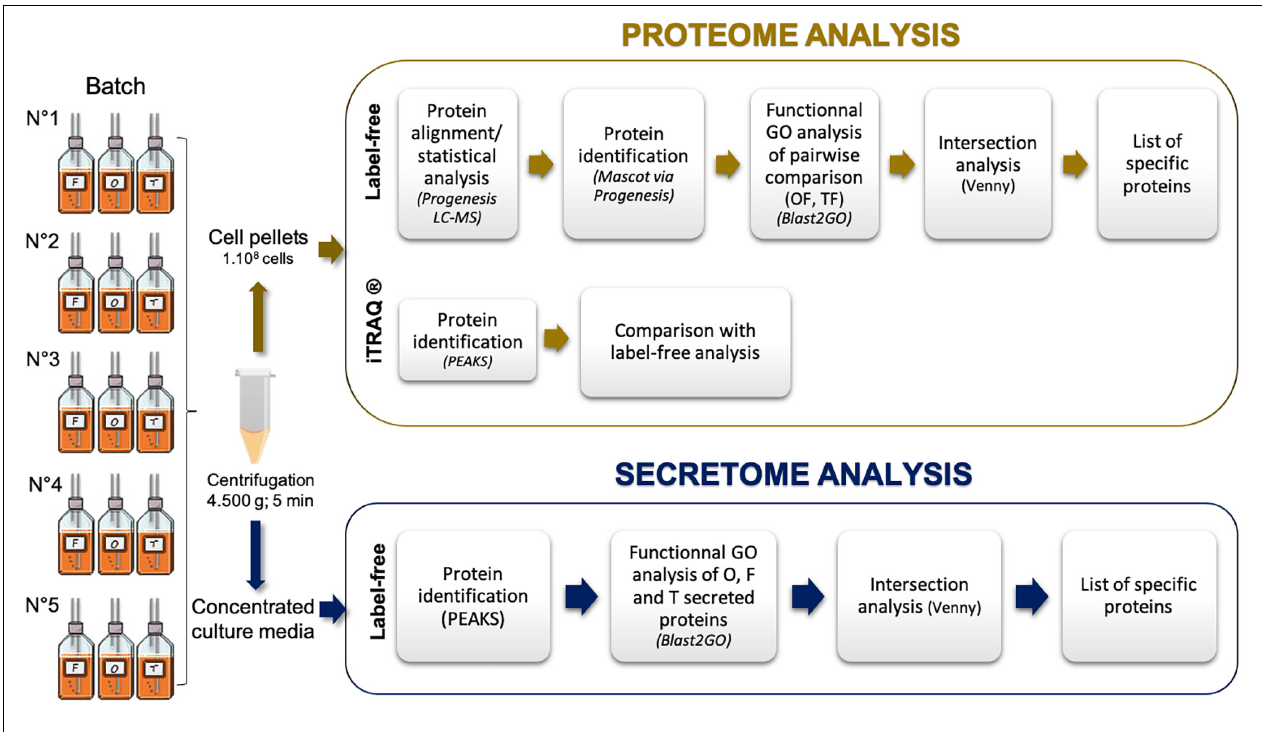
FIGURE 1 | Experimental design used in the current study to identify the intracellular proteomes and secreted proteins of the three main morphotypes of Phaeodactylum tricornutum . F, fusiform morphotype; O, oval morphotype; T, triradiate morphotype. Five biological replicates have been performed and summed for the data